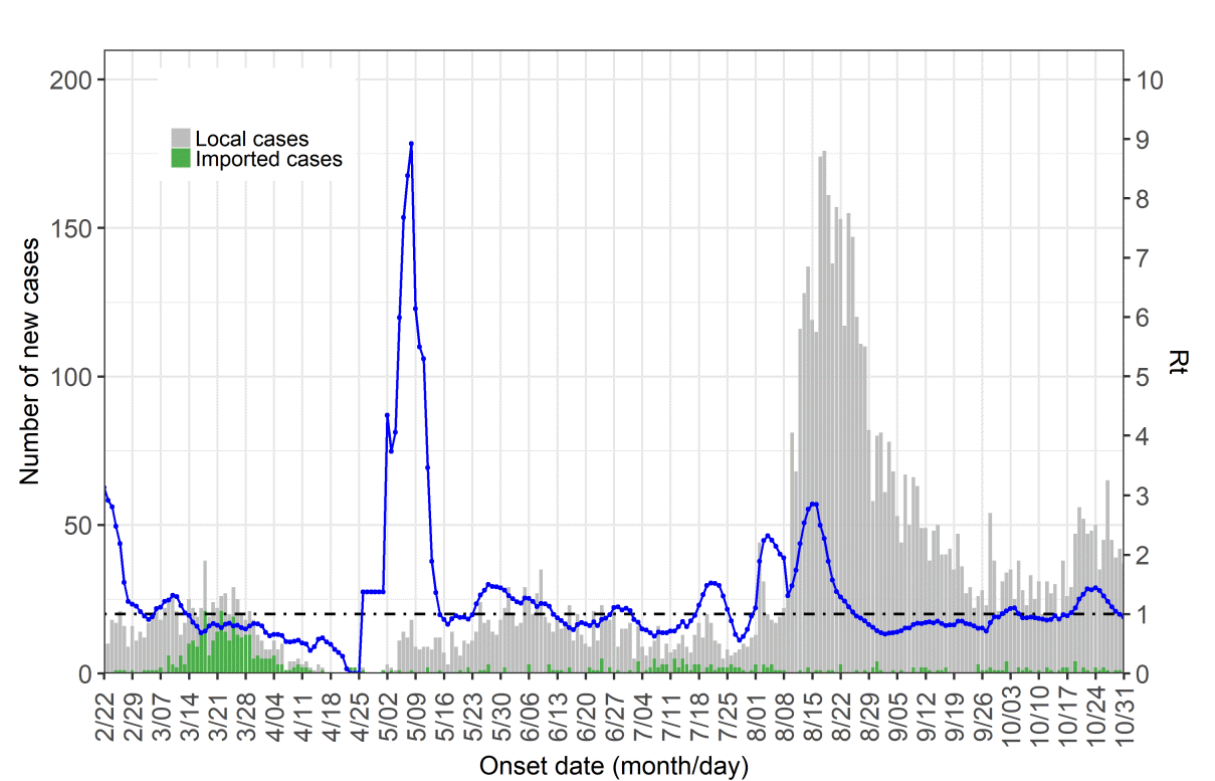
Figure 6. Local and imported cases and R t in Seoul and Gyeonggi. The daily epidemic curves of imported (green) and local (gray) cases are shown. The blue curve shows the value of R t when α =0.07 and the black horizontal line denotes R t